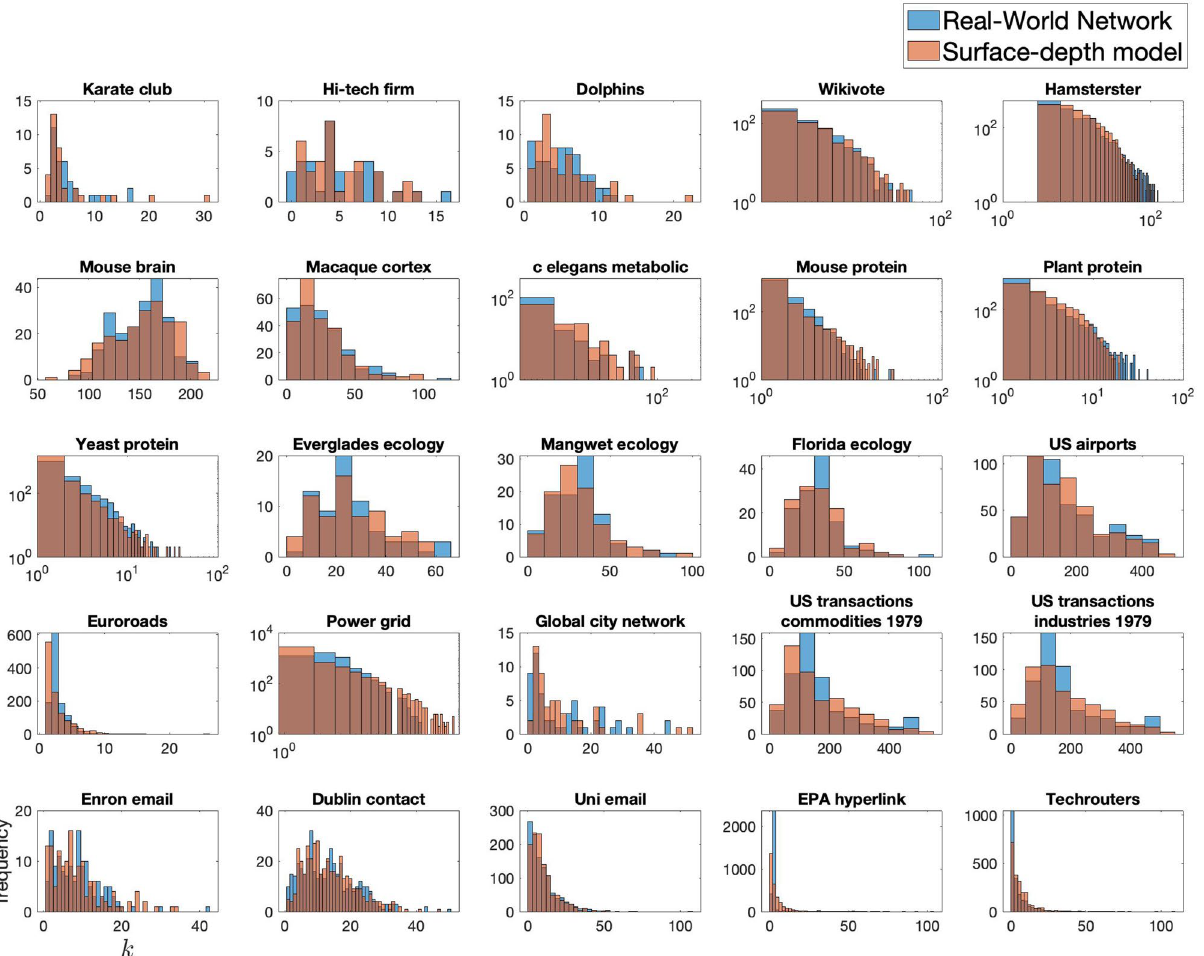
Figure 3. Comparison of the degree distributions between real-world networks and their respective closest fit surface-depth model. These are log–log plots where there is a clear scaling distribution. Axes as in bottom left plot—degree, k , against